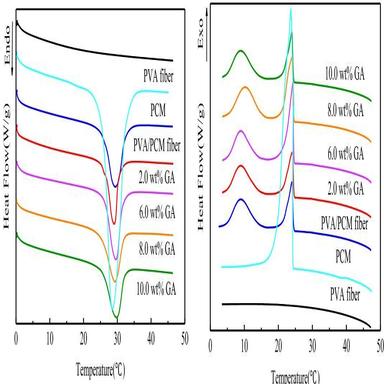
DSC curves of PCM, PVA fibers, PVA/PCM fibers and cross-linked PVA/PCM fibers in different dosages of GA.